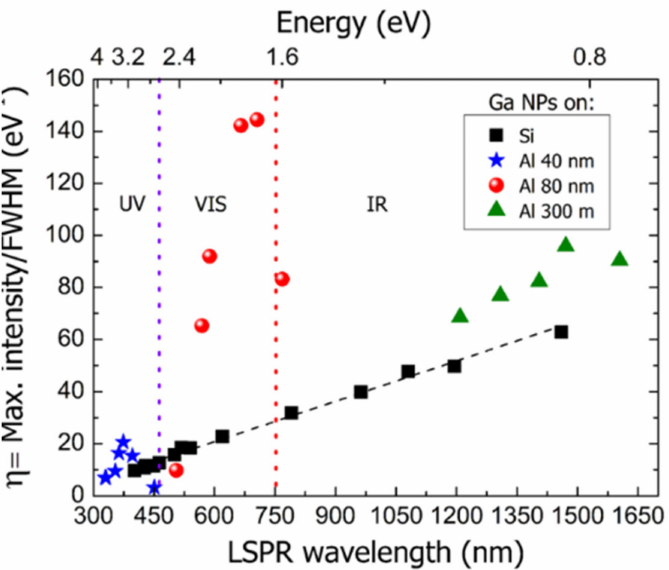
Figure 16. The figure of merit, η (calculated as the maximum intensity over the FWHM) show higher values for longer wavelengths, for Ga NPs is presented for Al and Si templates. Reproduced with permission from